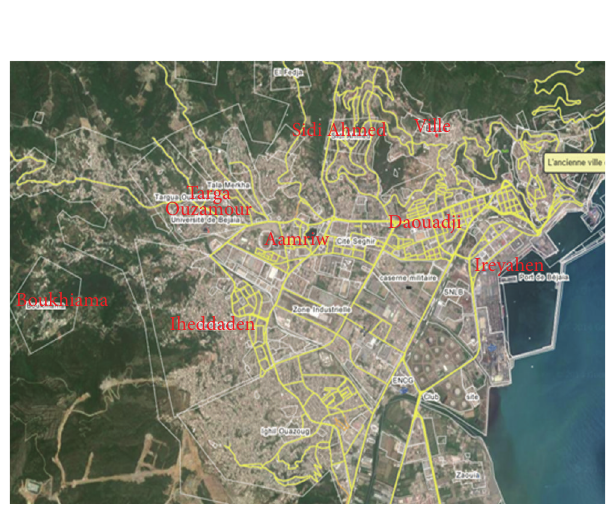
Figure 1: Bejaia: map of sampling